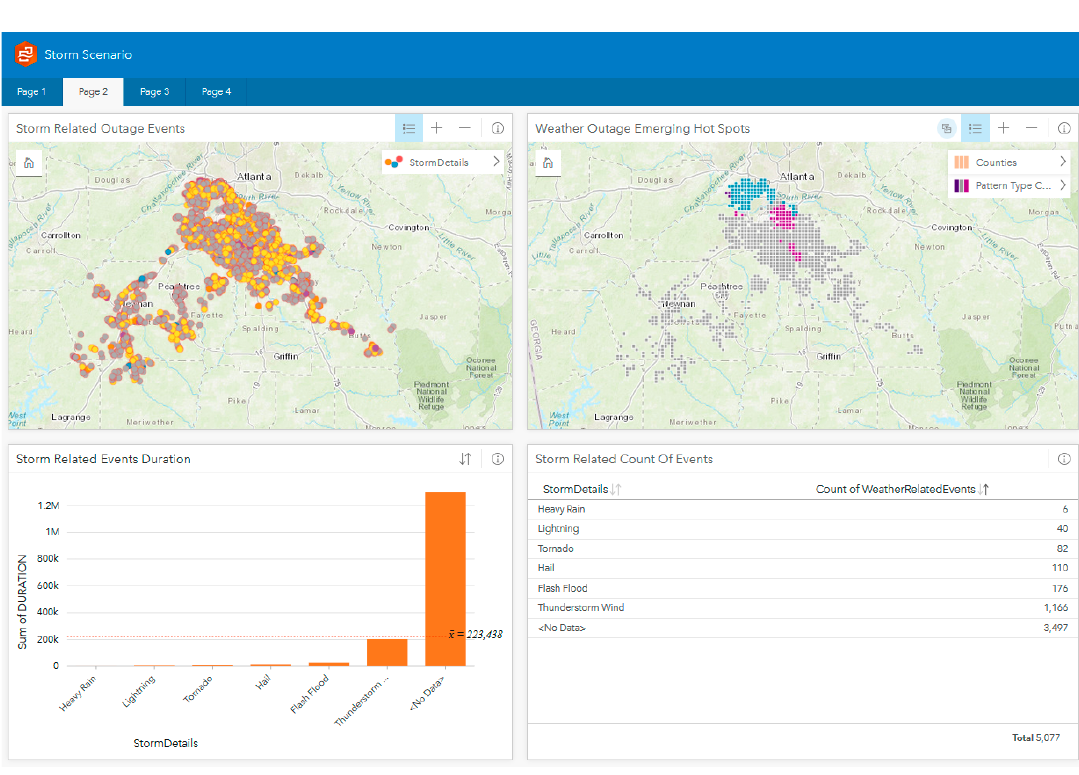
Figure 3. Challenge 1—Storm Scenario Workbook—Page 1.